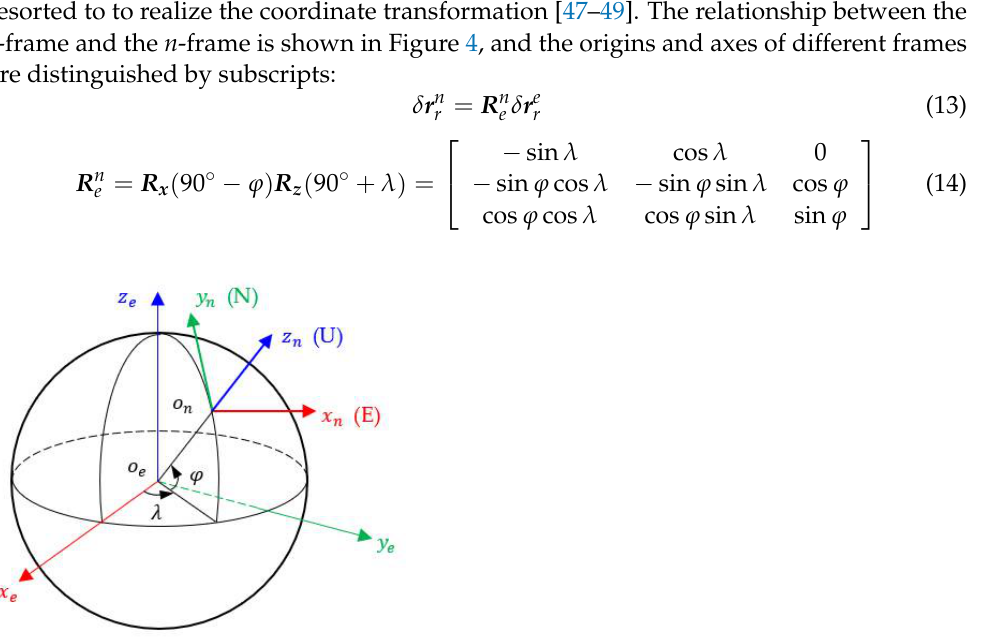
Figure 3. Illustration of the heading and pitch angle computation using the delta position vector of the receiver expressed in the navigation frame ( n -frame).